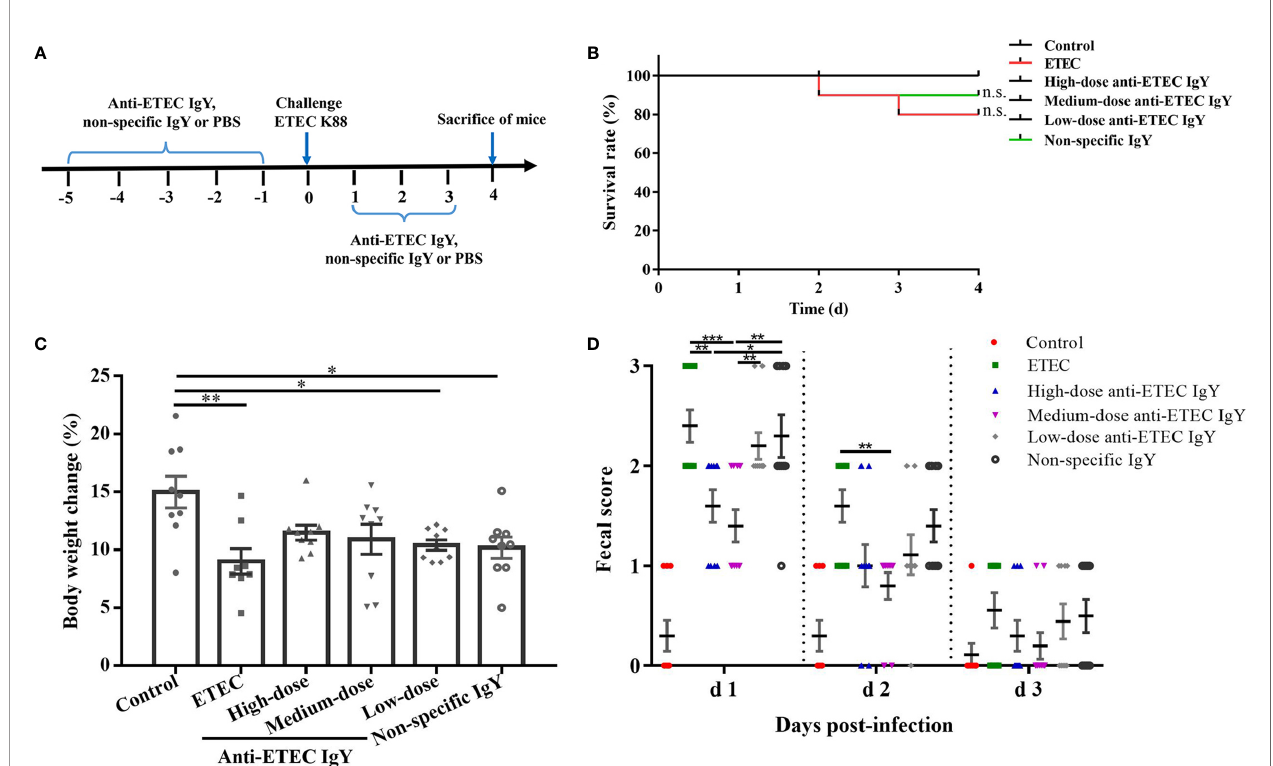
FIGURE 4 | Effects of IgY on clinical signs of ETEC-infected mice. (A) Schematic diagram of the experimental design for the protective effects of anti-ETEC K88 IgY on ETEC infection in mice. (B) Survival rate of control (neither IgY nor ETEC K88 infection) mice, ETEC-infected mice, ETEC-infected mice treated with high-, medium- or low-doses of anti-ETEC K88 IgY, or ETEC-infected mice treated with non-speci fi c IgY (n=10/group). (C) Body weight change of control mice, ETEC- infected mice, mice treated with high-dose, medium-dose or low-doses anti-ETEC IgY or non-speci fi c IgY groups (n=9 except n=8 for ETEC group). (D) Fecal score on different days after ETEC K88 infection in mice (d1, n=10; d2, n=10; d3, n=9). Fecal scoring scale was performed from 0 to 3 (0, dry stool; 1, slight sticky stool; 2, soft stool; 3, liquid stool). Values reported are least squares mean ± SEM. * P < 0.05, ** P < 0.01, *** P < 0.001, ns, not signi fi